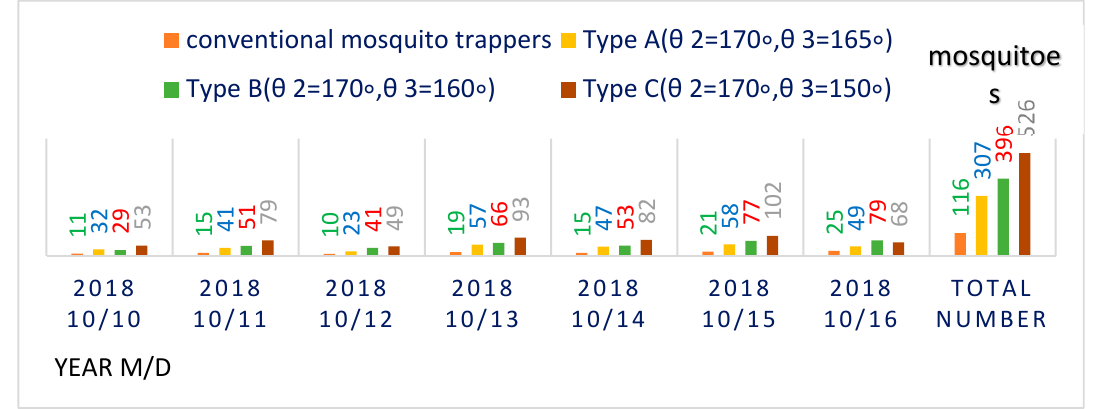
Figure 11. Comparison of proposed mosquito trapper with three different optimized reflectors and the conventional trapper with regard to mosquito trapping numbers.